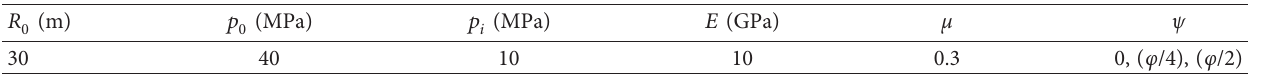
Table 1: Parameters.